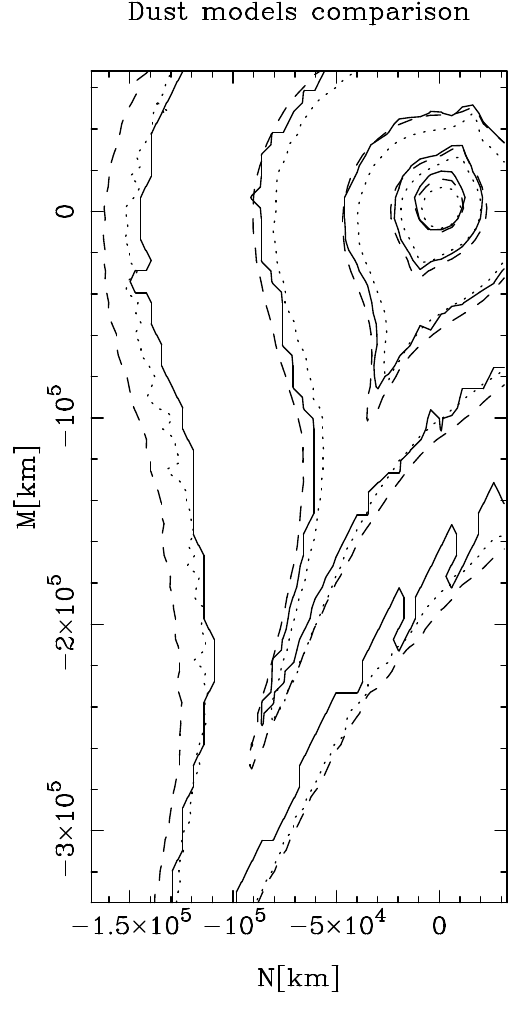
Figure 1. Isophote contours of the Trieste (M. Fulle, solid lines), Granada (F. Moreno, dotted lines) and trail (J. Agarwal, dashed lines) codes, modeling the 67P TNG image acquired on 27 March 2003, at r h = 2.6 AU post-perihelion with isotropic dust ejection. Adopted from [71].